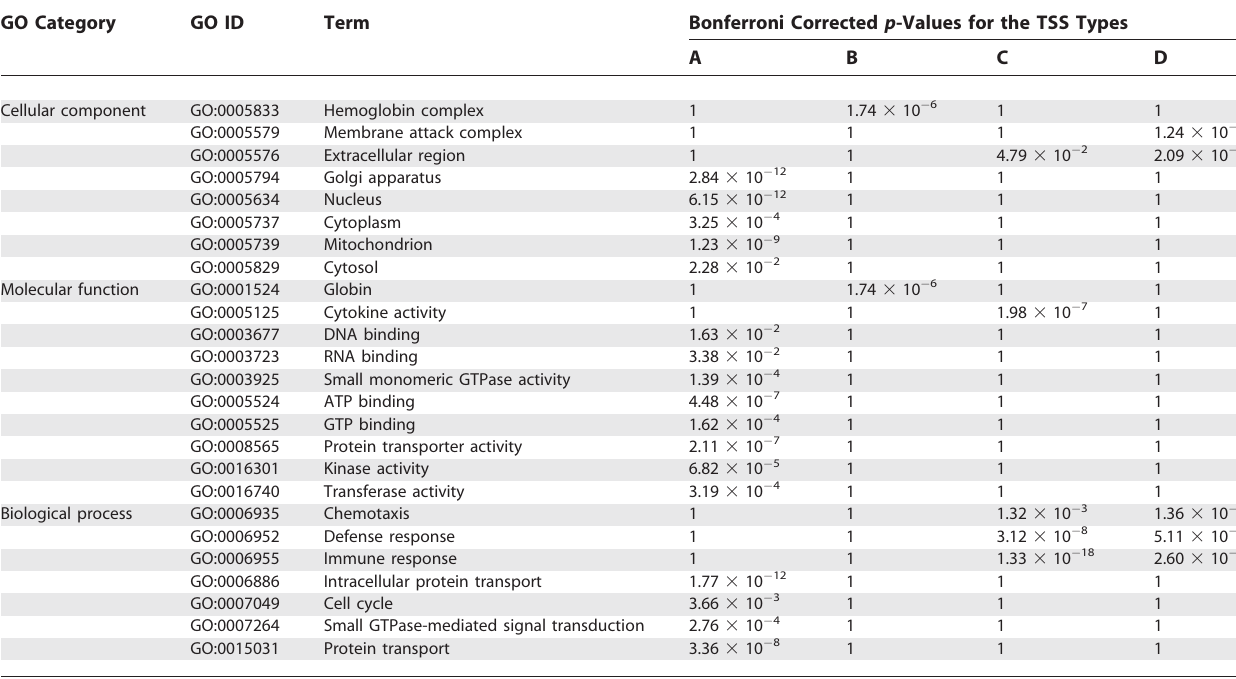
Table 5. Enrichment of TSS Types in Selected GO Categories in Mouse GO